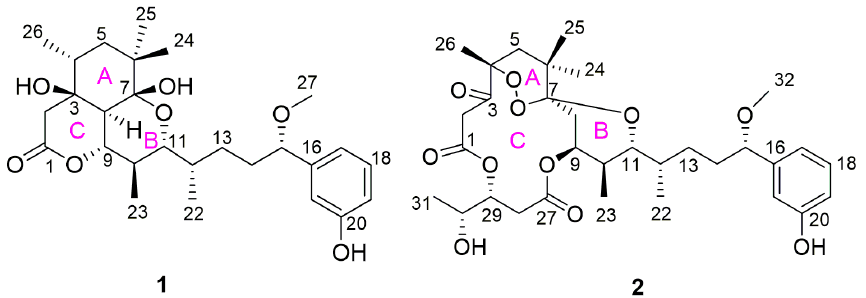
Figure 1. Structures of neo-debromoaplysiatoxin I ( 1 ) and neo-debromoaplysiatoxin J ( 2 ).